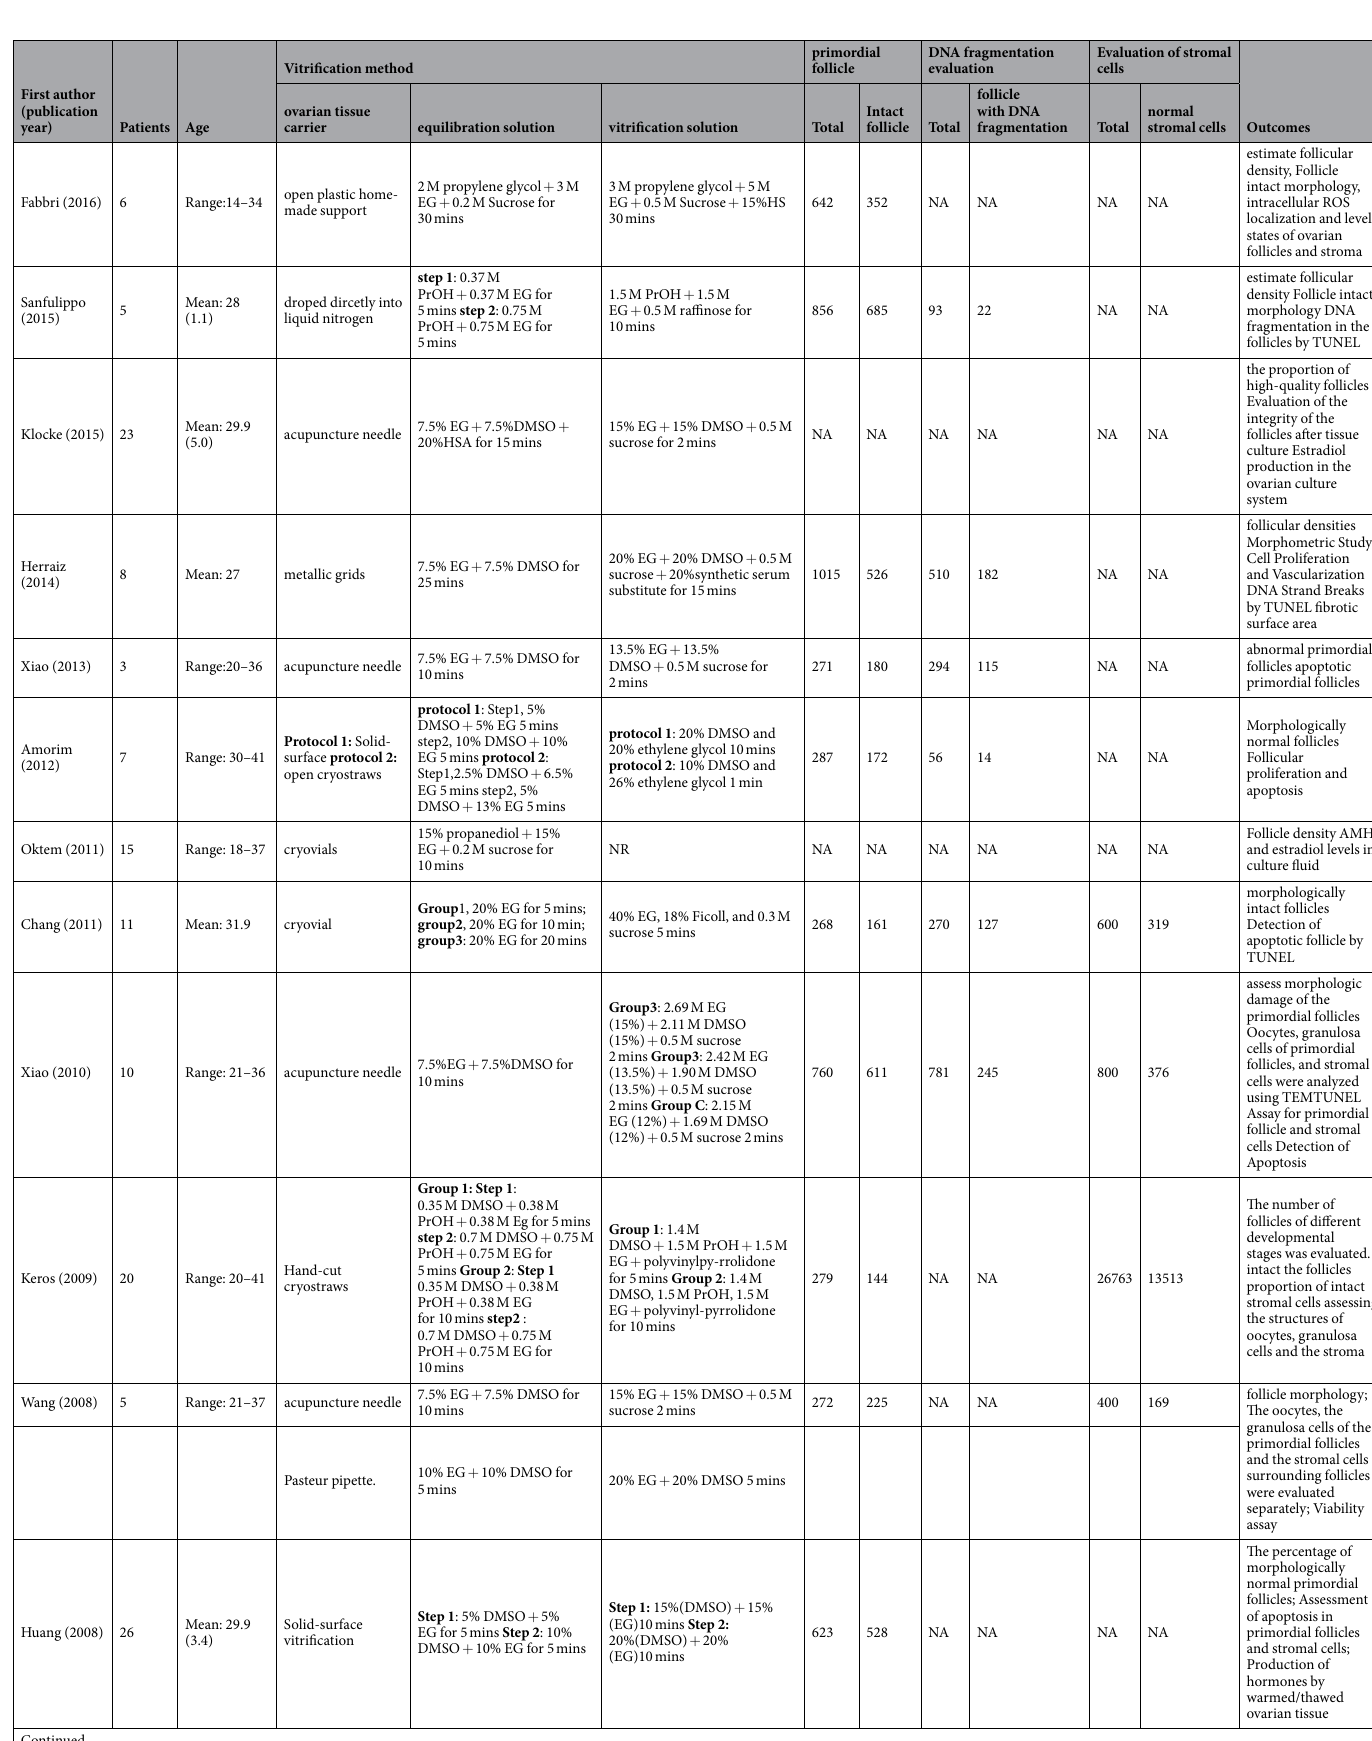
assayPasteur pipette.